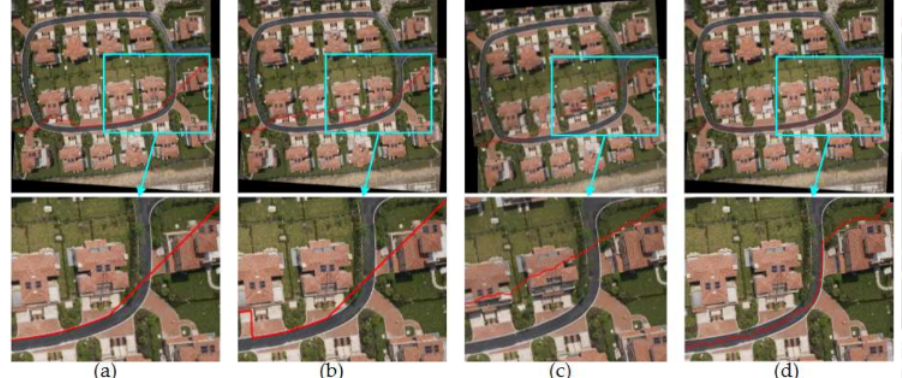
Figure 11. The seam-lines of different search methods for Figure 7d: ( a ) Dulapquet3-DP; ( b ) Dulapquet4-DP; ( c ) OpenCV-DP; ( d )